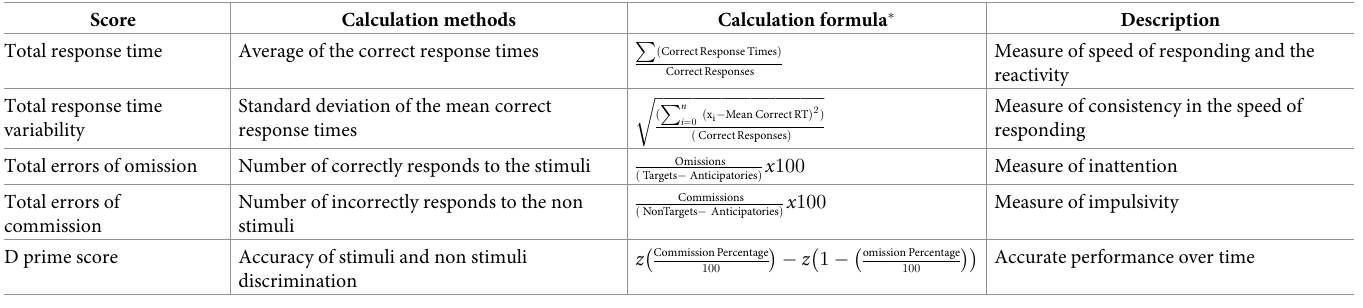
Table 1. Calculation methods and score description in the TOVA